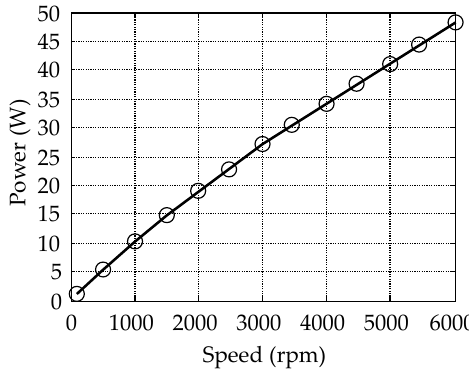
Figure 9. Calculated values of hysteresis thermal power.